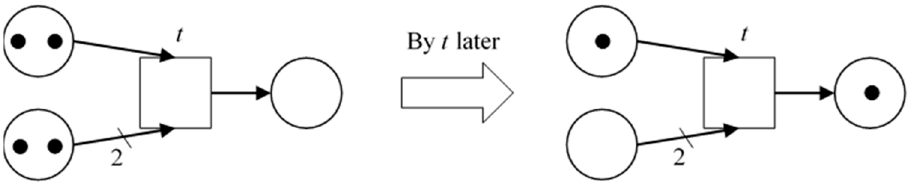
Figure 2. Example of an enabled transition.